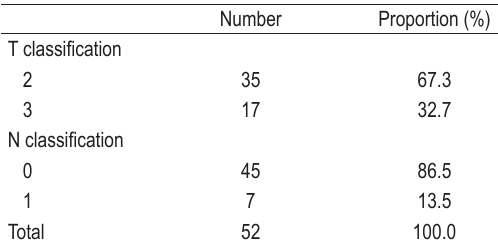
TABLE 2. pTNM stage of 52 cases of prostatic